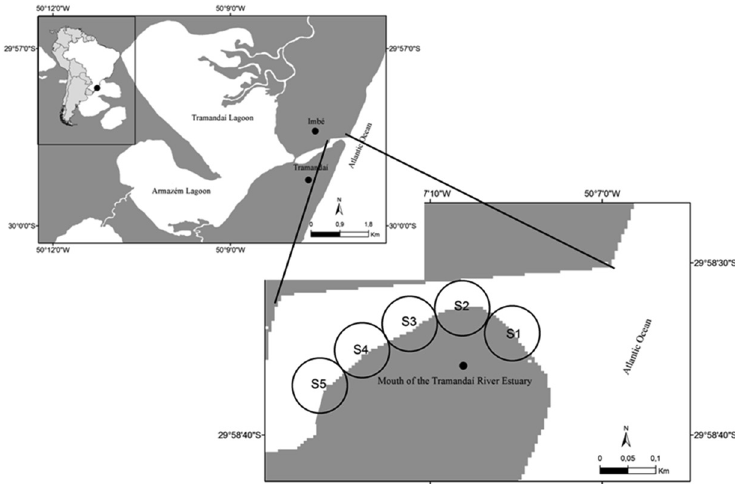
Figure 1. Study area and sampled fishing sectors (sampling sectors) in the Tramandaí River Estuary (TRE) in southern Brazil. The circles represent the sectors